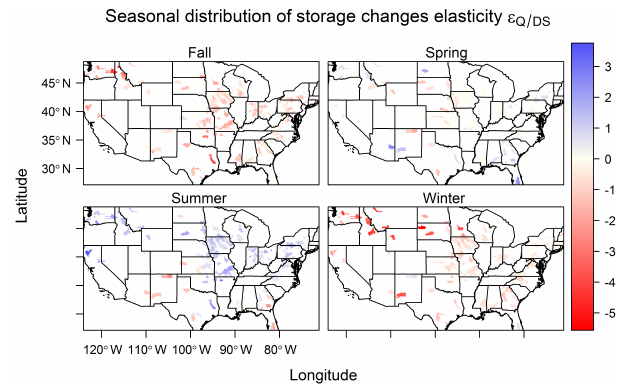
Figure 9. Seasonal distribution of streamflow elasticity due to stor- age change (dimensionless).